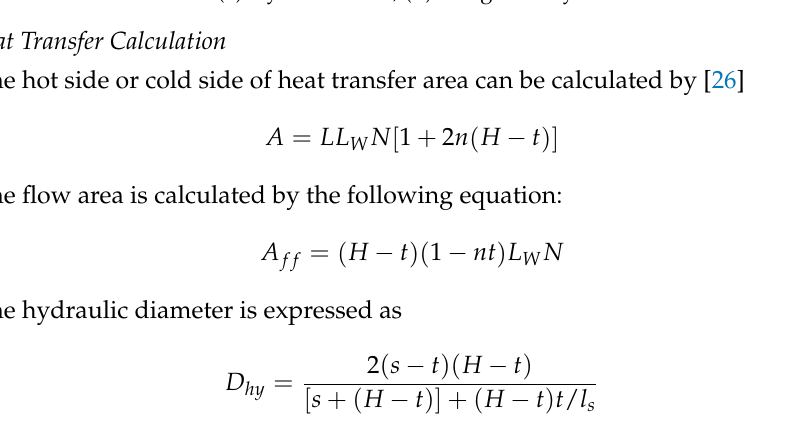
Figure 1. Schematic of PFHE: ( a ) layer structure; ( b ) fins